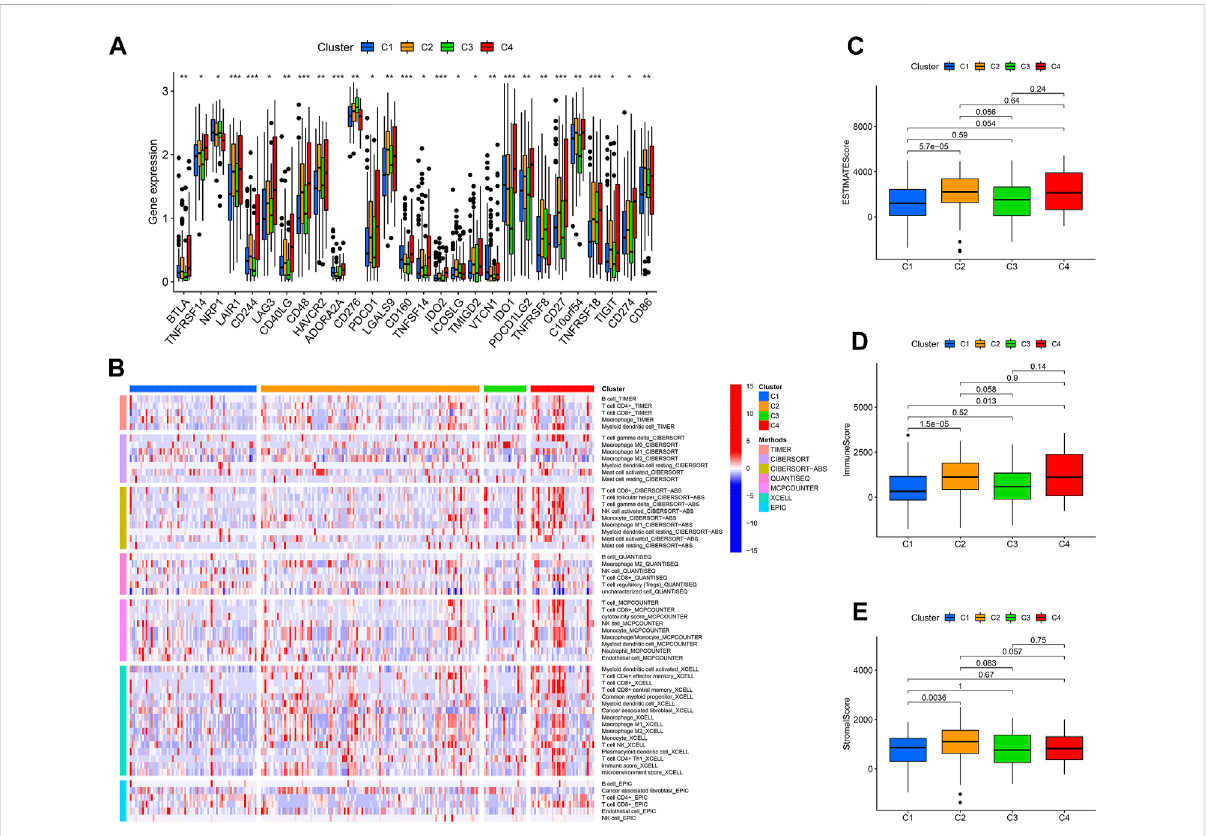
FIGURE 6 The immune landscape of four cuproptosis lncRNA clusters. (A) Variable expression of immune checkpoint-related genes in different clusters. (B) The enrichment levels of immune cells in different clusters (All p values < .05). The estimate score (C) , immune score (D) , and stromal score (E) were in the four clusters. * p < .05, ** p < .01, *** p <